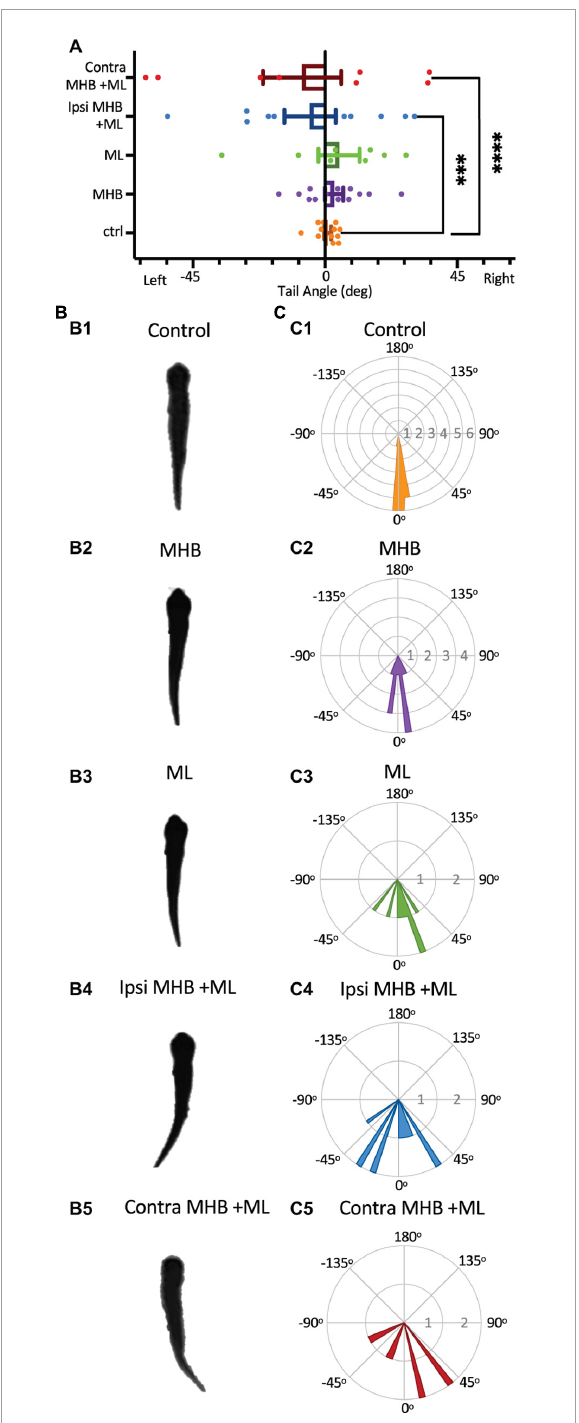
FIGURE7 Midbrain lesions cause tail deflections. (A) The mean tail angle at rest (no stimulus applied), prior to trunk skin stimulation. Ctrl: 0.9 o ± 1.1 o , n = 5 tadpoles, 12 trials; MHB: 3.1 o ± 3.1 o , n = 6, 13 trials; ML: 4.8 o ± 7.0 o , n = 4, 8 trials; Ipsi MHB + ML: –5.1 o ± 8.7 o , n = 5, 10 trials; Contra MHB + ML: –7.8 o ± 13.3 o , n = 4, 8 trials. Reported as mean ± SEM. Single data points are plotted, the middle horizontal line represents the mean, and